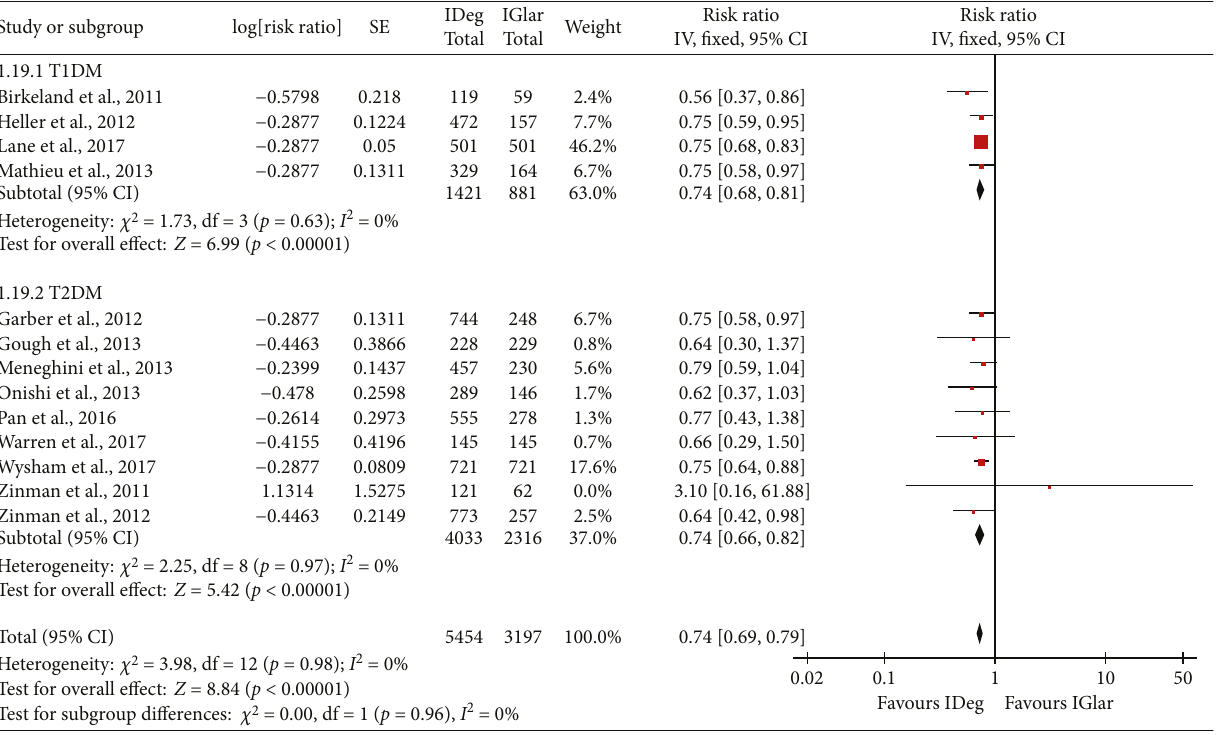
Figure 4: Comparison of the risk of nocturnal hypoglycemia (events per patient-year of episode) between IDeg and IGlar across subgroups: the abbreviations are the same as Figure